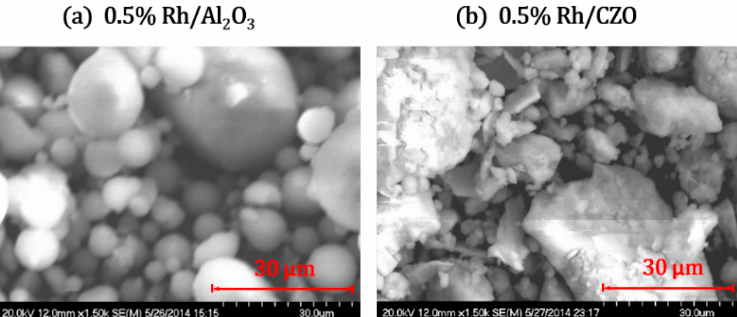
Figure 15. Scanning Electron Microscopic (SEM) images of fresh ( a ) 0.5% Rh/Al 2 O 3 and ( b ) 0.5% Rh/CZO at µm scale. SEM measurement condition: beam voltage of 20 kV, beam current of 10 µm, working distance of 12 mm, and 30 µm in